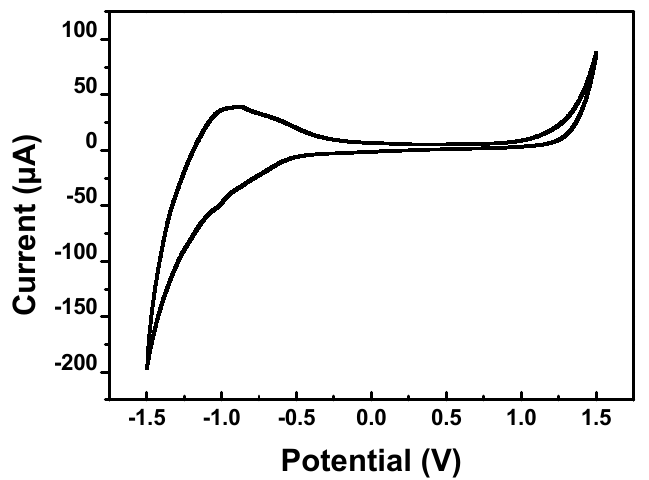
Figure 3. The CV curve of the WO 3 -modified electrode in the Cd 2+ standard solution.